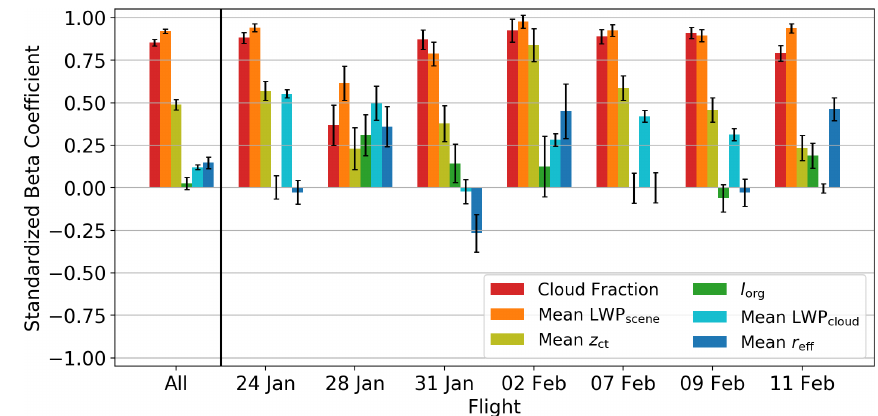
Figure 5. Beta coefficients demonstrating the relative correlation of different cloud properties and the organization of the cloud field to α ce for the subset of flights (all) and individual